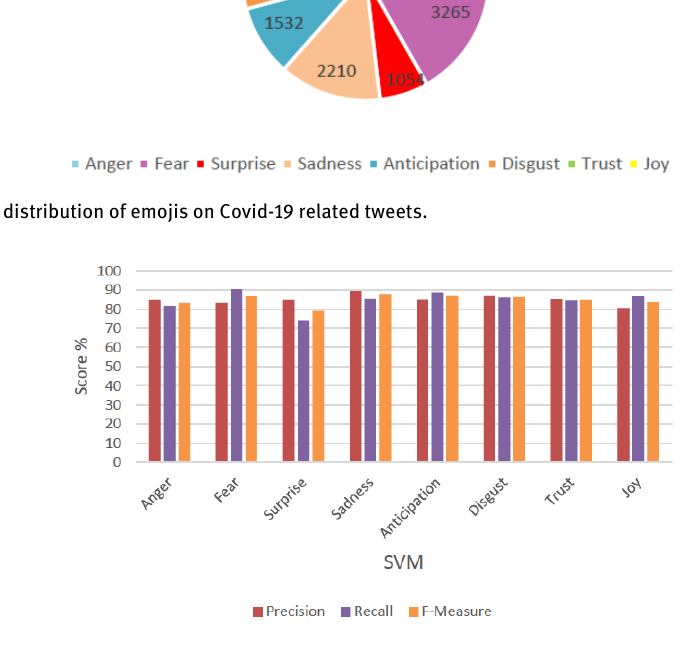
Figure 11: Sentiment prediction for